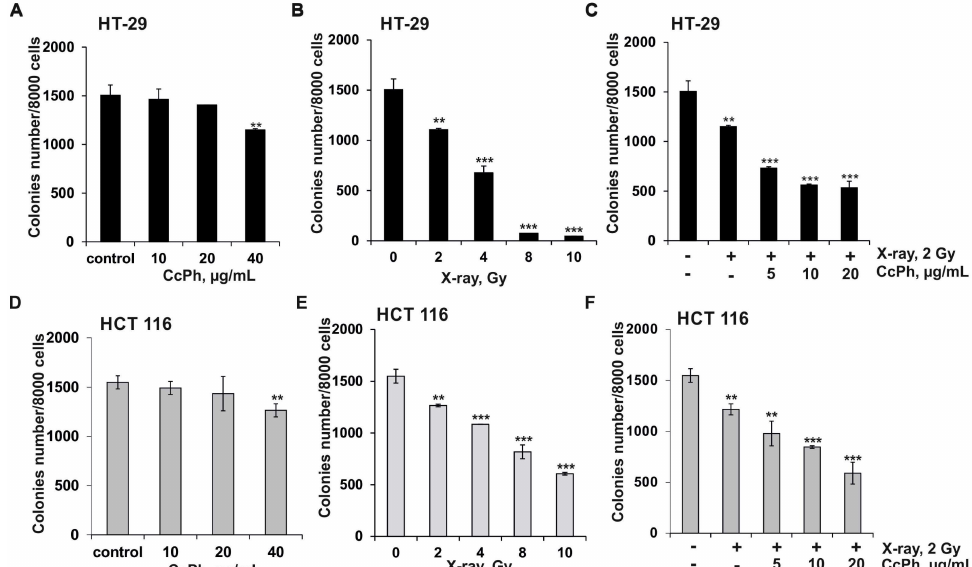
Figure 2. Anticancer and radiosensitizing e ff ects of phlorethols from C. costata ( CcPh ) on colony formation in human colorectal carcinoma cells. HT-29 and HCT 116 cells (2.4 × 10 4 ) were treated with ( A,D ) CcPh (10, 20, and 40 µ g / mL) or ( B,E ) X-ray (2, 4, 8, and 10 Gy) or ( C,F ) a combination of X-ray radiation (2 Gy) and CcPh (5, 10, and 20 µ g / mL) and subcultured onto Basal Medium Eagle BME soft agar and incubated for 2 weeks. The number of colonies was calculated using the ImageJ software bundled with 64-bit Java 1.8.0_112 (NIH, Bethesda, Maryland, USA). All experiments were repeated at least three times in each group. Results are expressed as the mean ± standard deviation (SD). The asterisk (*) indicates a significant decrease in the number of colonies of cancer cells treated with CcPh or X-ray compared to PBS-treated cells or CcPh in combination with X-ray compared to irradiated cells (** p < 0.01, *** p <